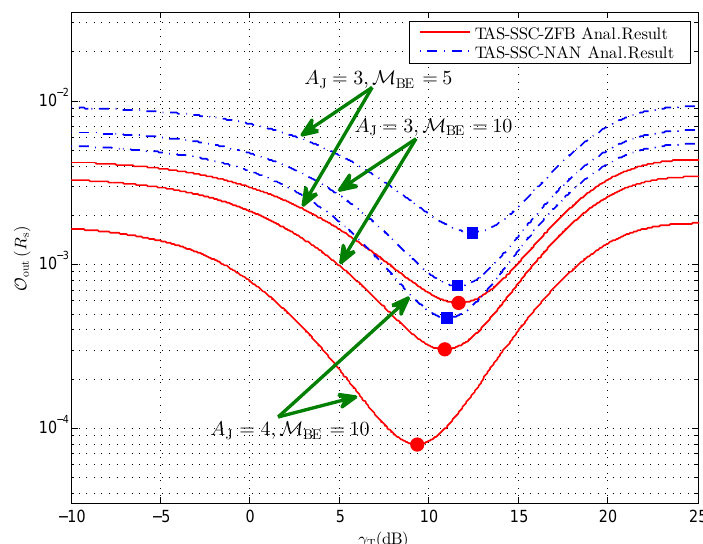
Figure 4. Secrecy outage probability versus different γ T for A A = 2, N B = 2, R s = 1, γ S = 20 dB, and φ = 0.5.